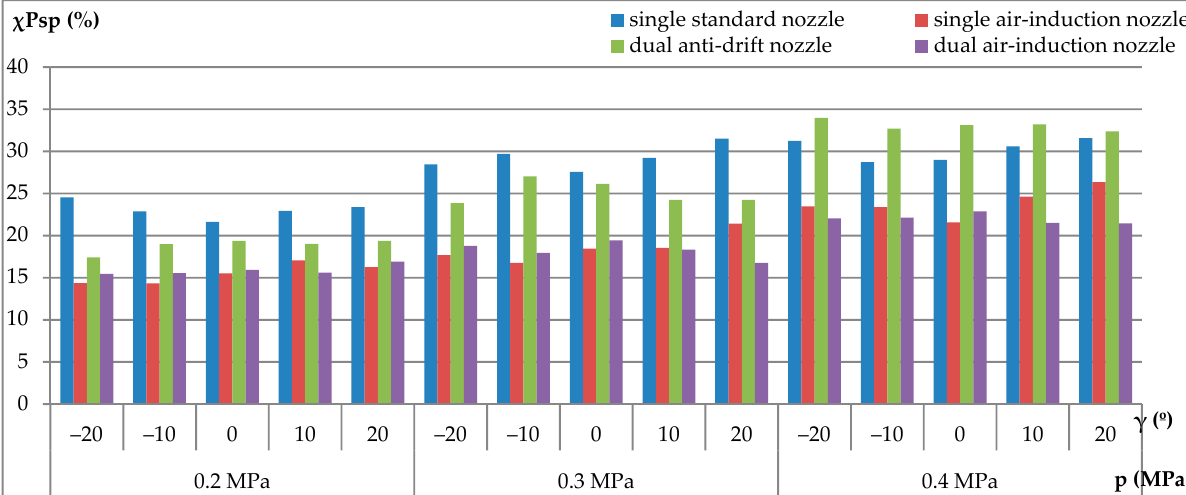
Figure 3. Average degree of coverage for selected nozzles at 2.2 m ∙ s − 1 driving speed.